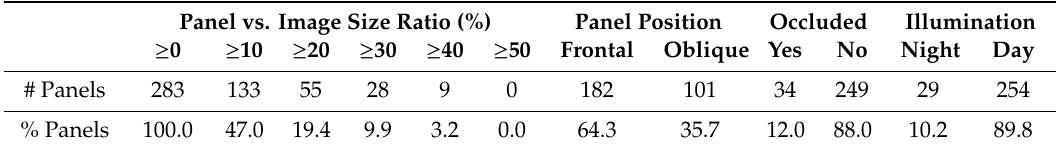
Table 2. Panel distribution of variabilities in the test dataset.